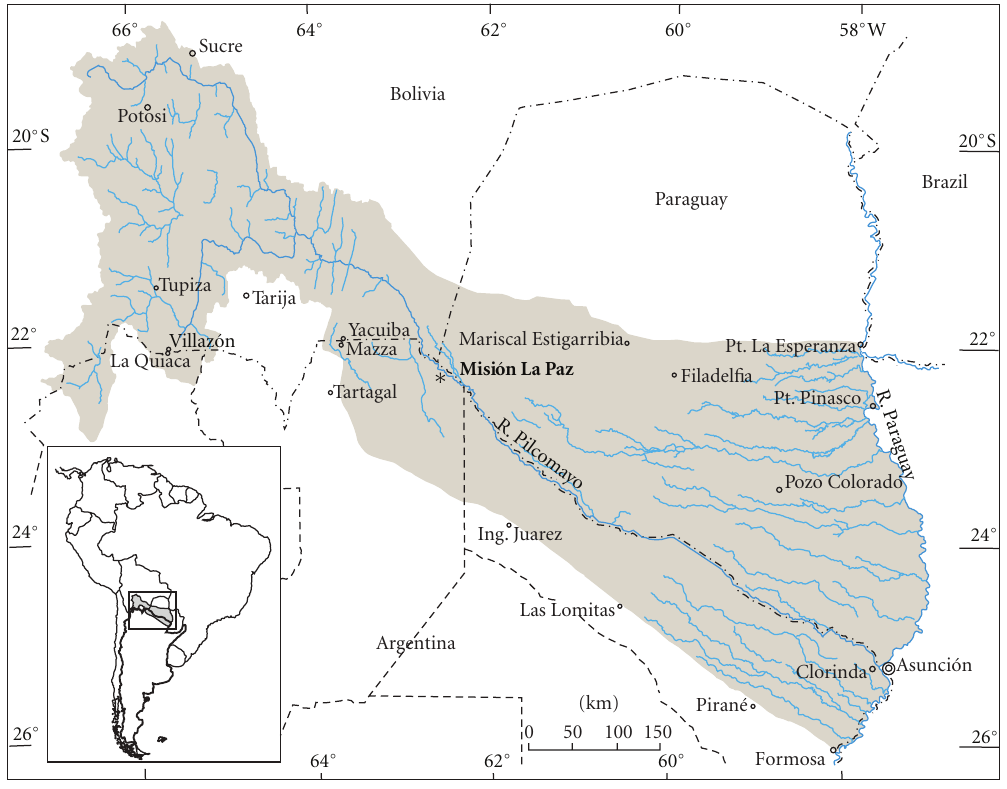
Figure 1: Map of the Pilcomayo River basin with the water sampling location (Misi´on La Paz, Argentina).